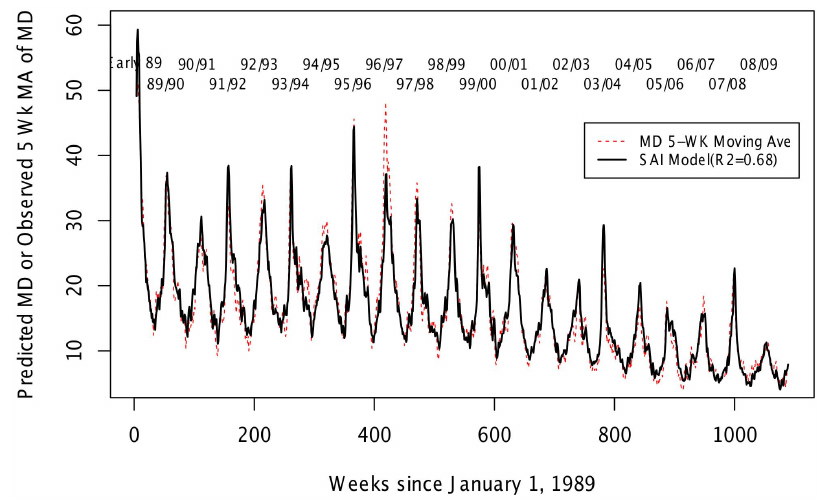
Figure 2. Observed MD compared with model-predicted MD. MD counts were modeled in a negative binomial generalized linear model with an identity link. Independent variables included a sinusoidal term for seasonal variation, linear and quadratic time trends (modeled using Legendre polynomials), autoregressive terms with MD lagged 1 2 3 weeks, SAIH lagged 1 week, and terms to allow influenza to have a changing effect on MD over time (effect modification).